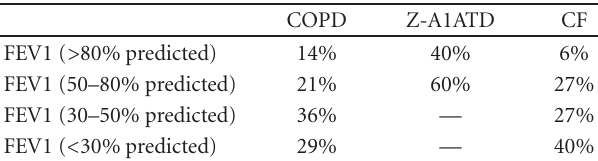
Table 2: The severity of disease in COPD, Z-A1ATD, and CF based on the predicted percentage of FEV1.